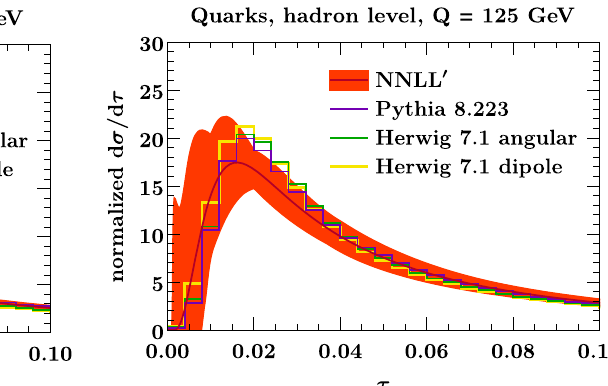
hadron level (right panel). The band in the left panel shows the per- turbative uncertainty in Eq. (13). In the right panel, it shows the sum of perturbative and nonperturbative uncertainties as in Eq. (17)